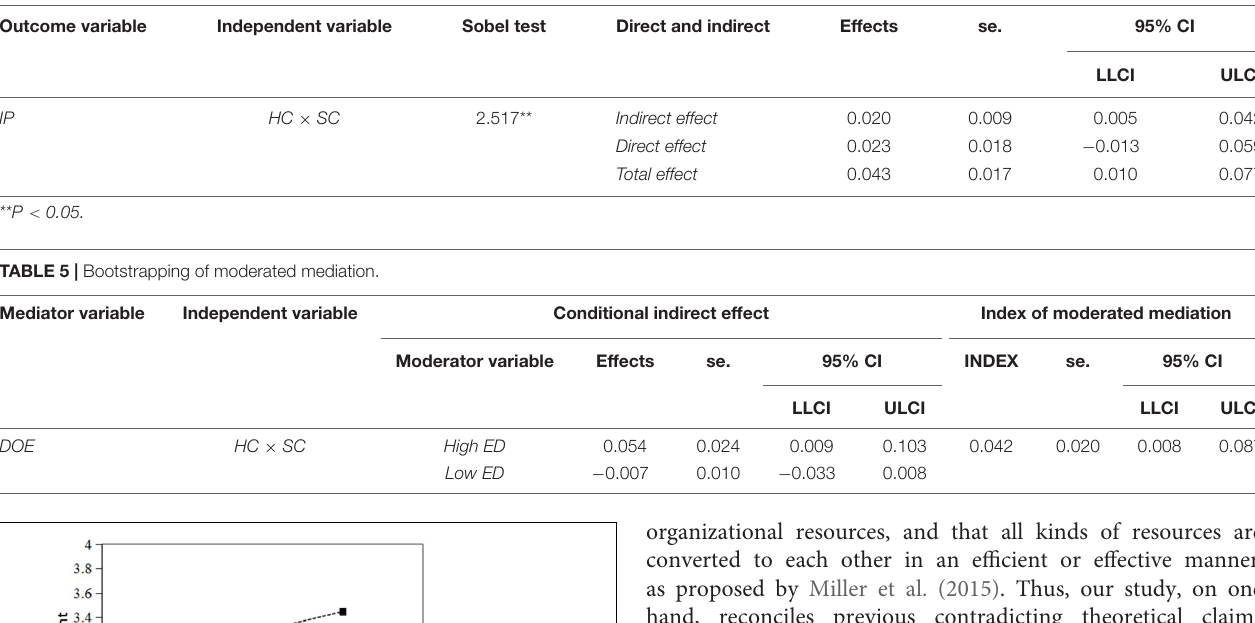
TABLE 4 | Bootstrapping of mediation effects.